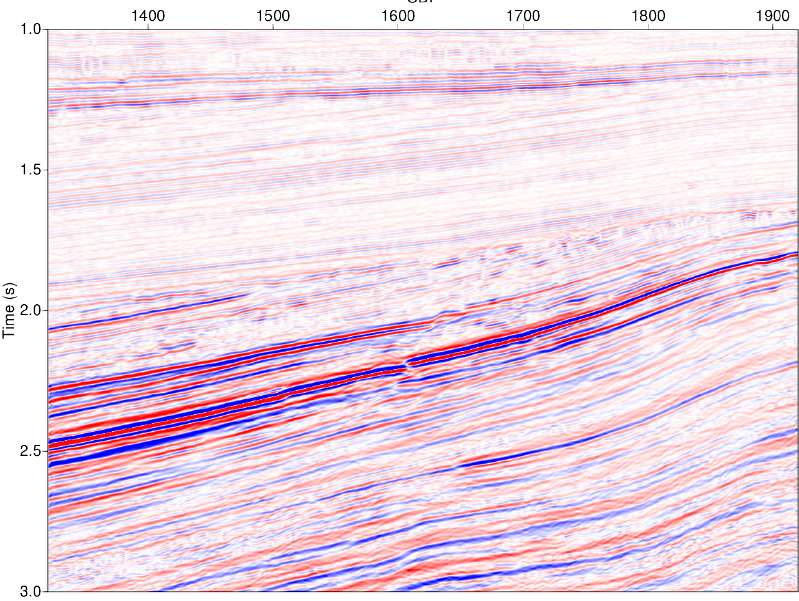
Figure 12. Predicted image using the proposed method. The proposed method can achieve the same imaging effect as that of the high-resolution imaging method, which requires a large computation time. Both the methods considerably improve the resolution and reflect detailed information of the